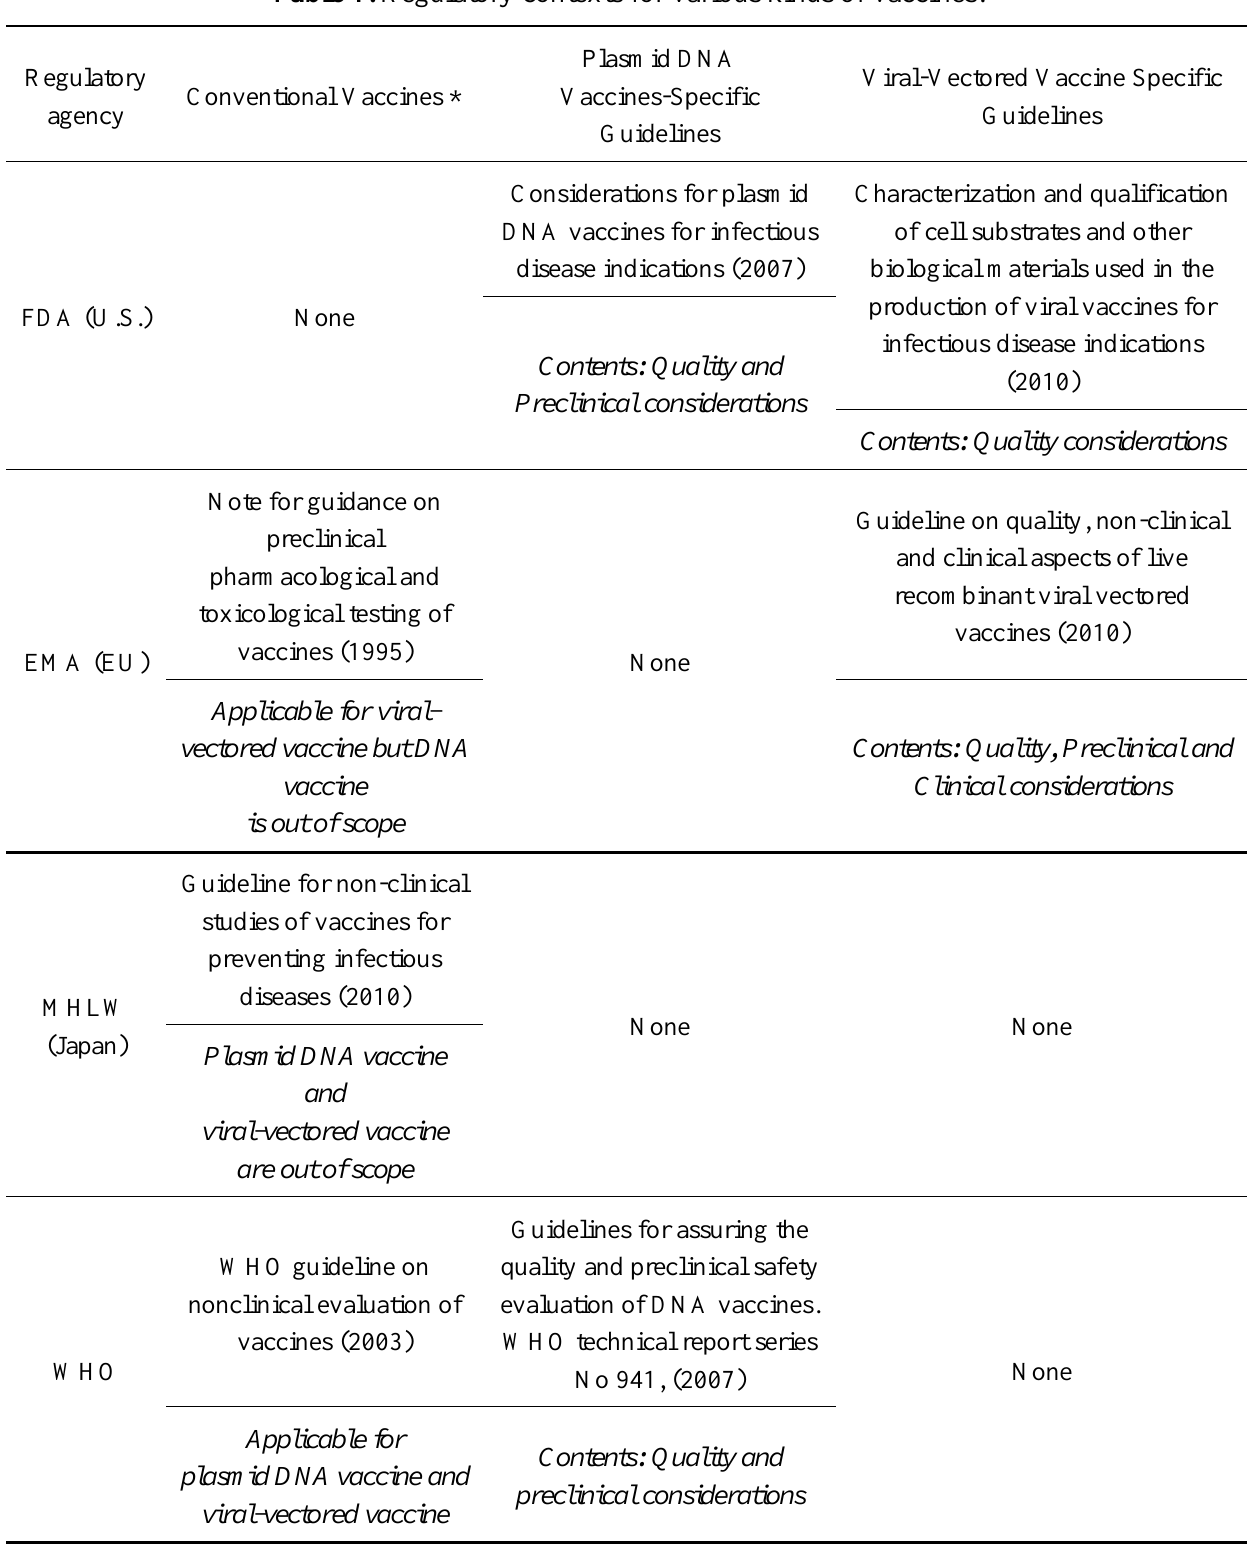
Table 1. Regulatory contexts for various kinds of